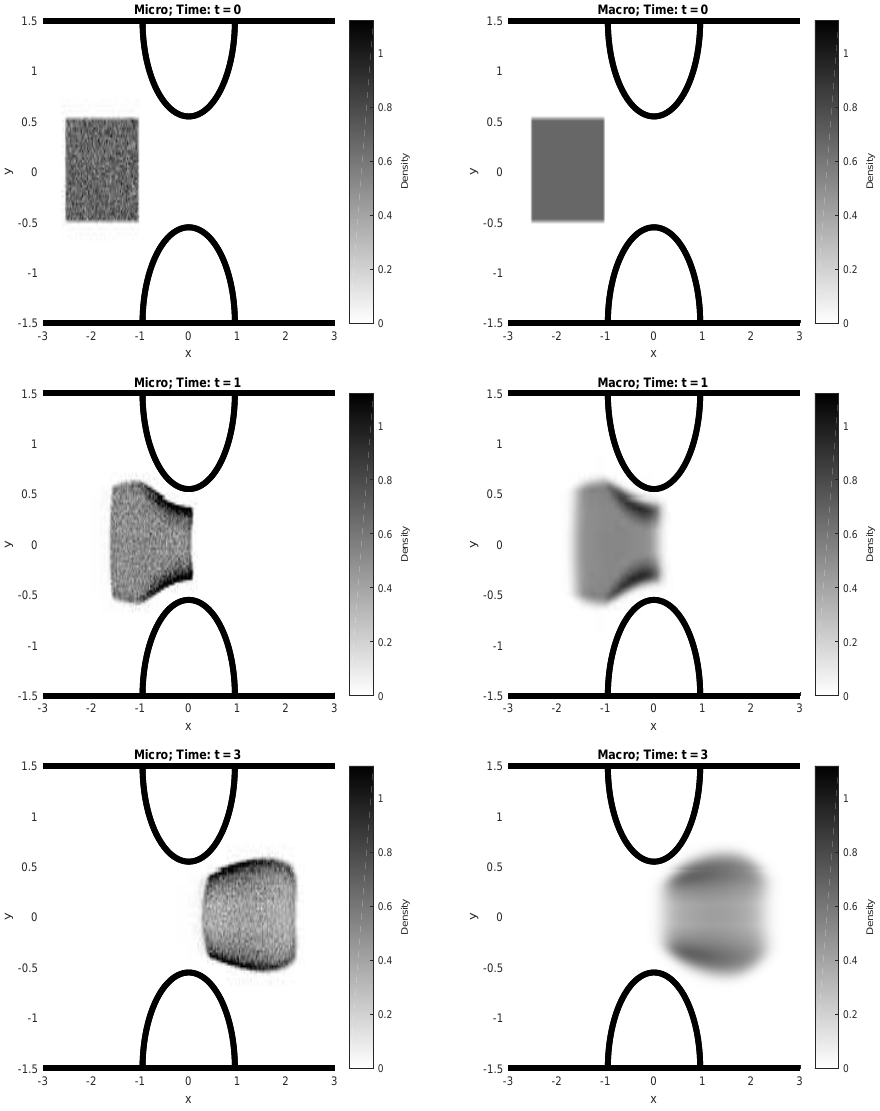
Figure 8: Densities for λ 2 at different